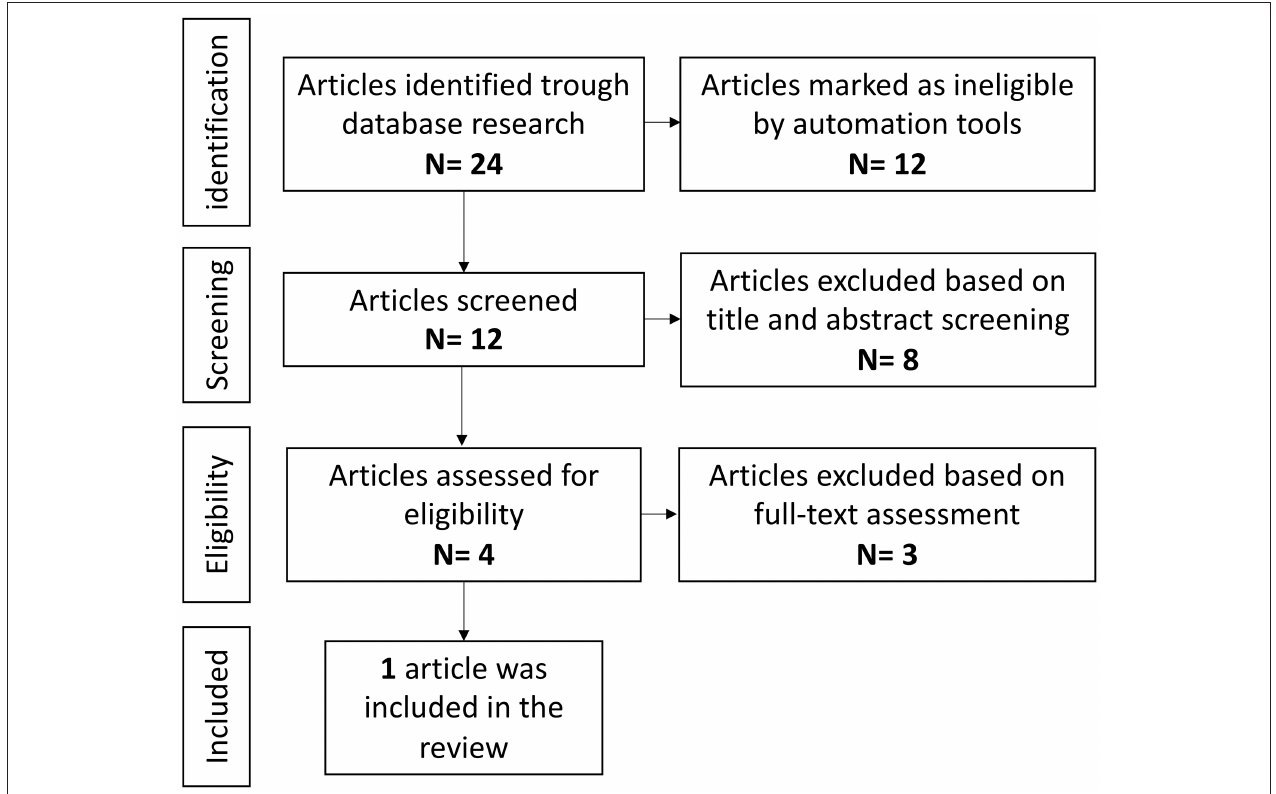
FIGURE 7 | Anti- α 4-integrin agents and epilepsy, literature review.